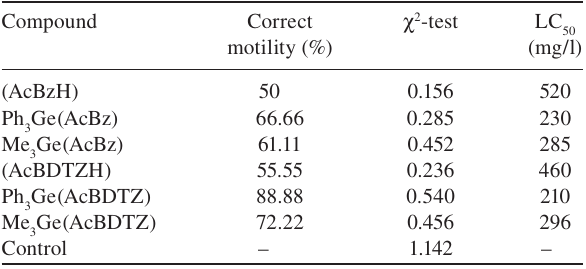
Figure 4 DNA cleavage gel diagram of synthesized